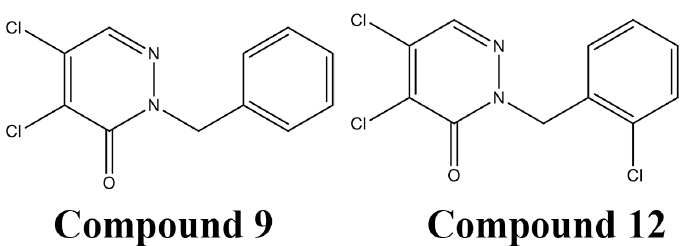
Figure 6. Structures of the most potent DsbB inhibitors identified by a high throughput screening method, compounds 9 (2-benzyl-4,5-dicholorpyridazin-3(2 H )-one) and compound 12 (4,5-dichloro-2-(2-chlorobenzyl)pyridazin-3(2 H )-one).